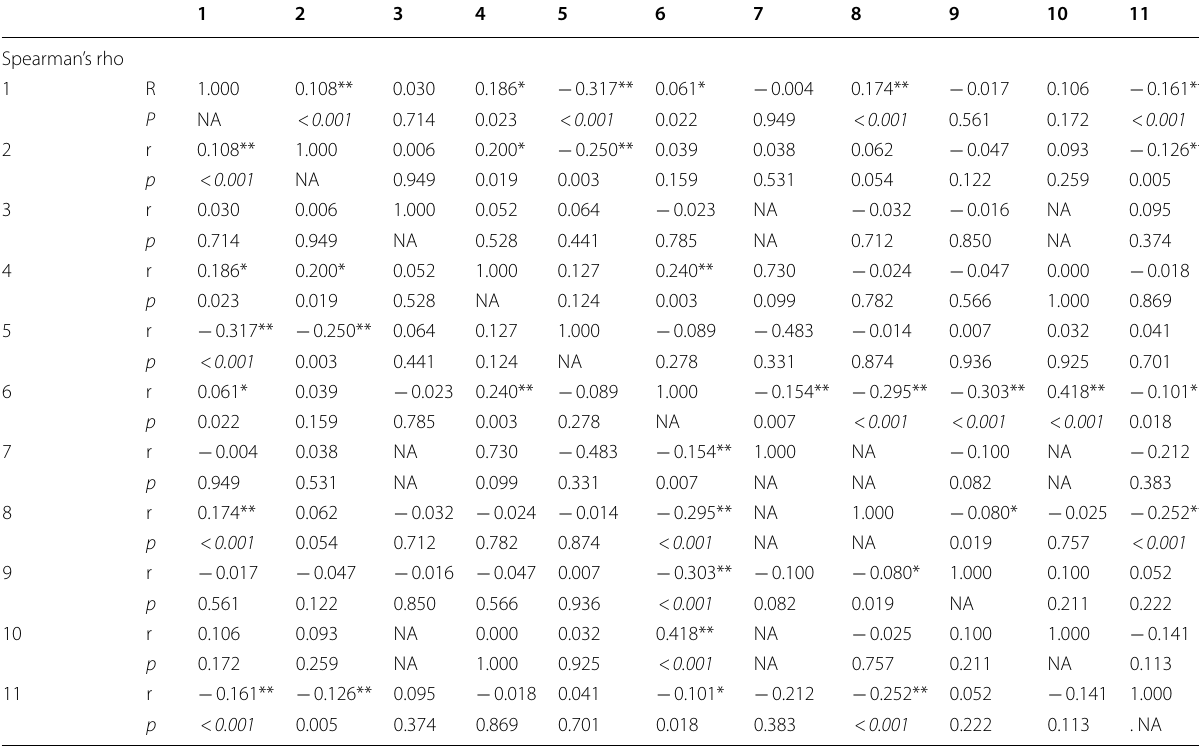
Table 4 Correlation matrix between some quantitative factors among the studied